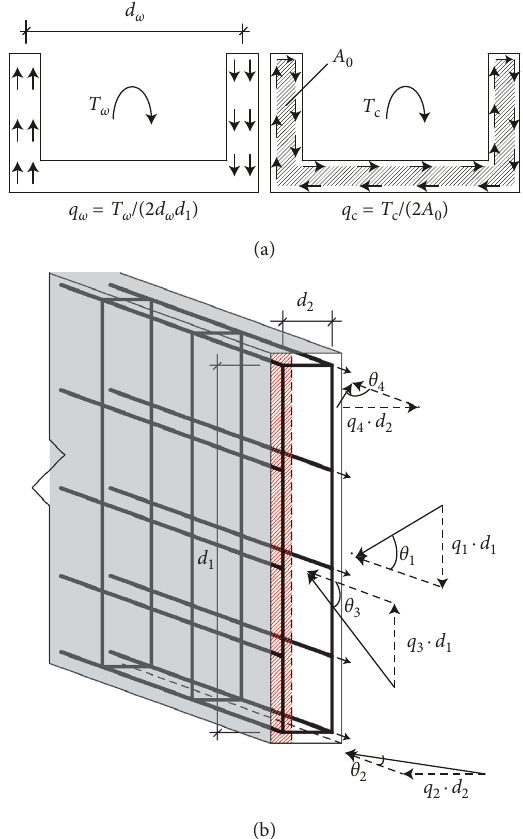
Figure 5: Ultimate equilibrium under the combined actions of warping torque and circulatory torque: (a) simplified distribution of torsional shear stresses and (b) ultimate equilibrium on the right web of the U-shaped